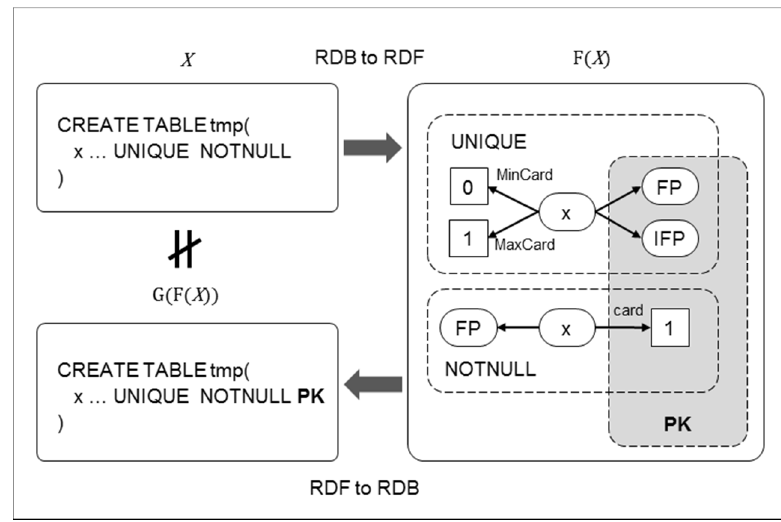
Figure A1. An example of Problem 3.